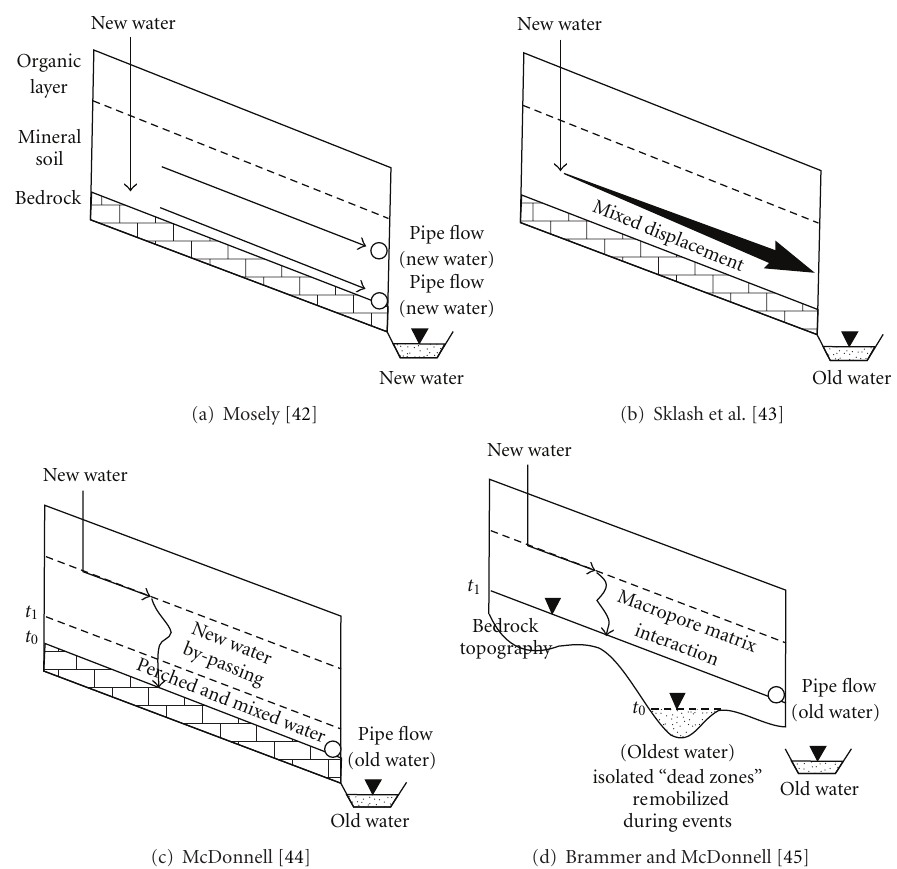
Figure 1: Changing conceptual understanding of subsurface flow in the Maimai catchment, New Zealand McGlynn et al. [46].